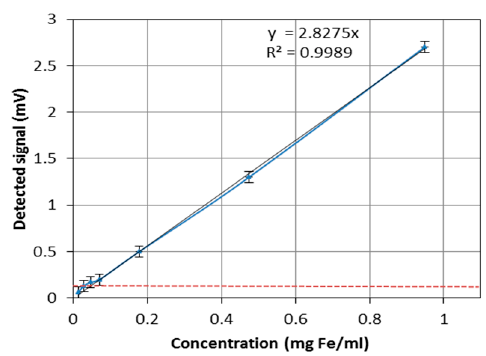
Figure 5. Magnetic response as a function of the mass concetration of iron nanoparticles. The red dotted line indicates the approximate limit of